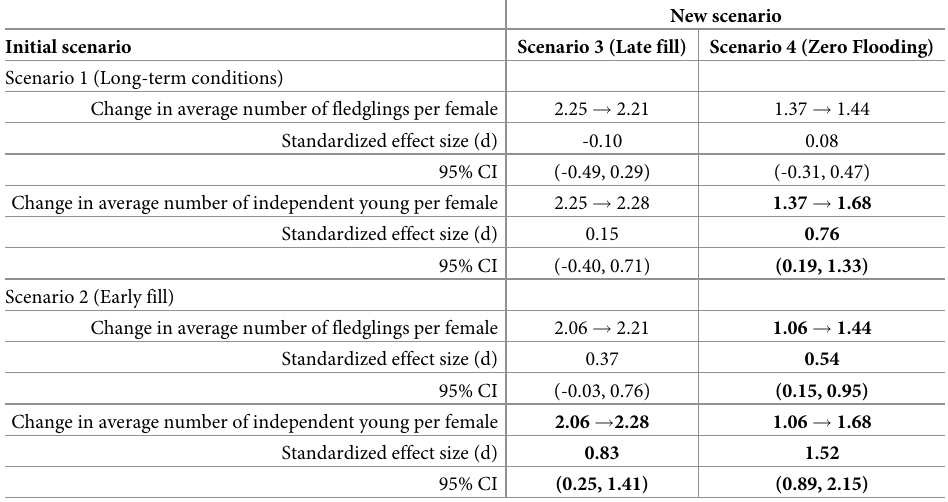
Table 2. Change in the estimated average productivity of female yellow warblers and the standardized effect sizes (Cohen’s d, 95% CI) associated with changing reservoir operations from Scenario 1 or 2 to Scenario 3 and 4.